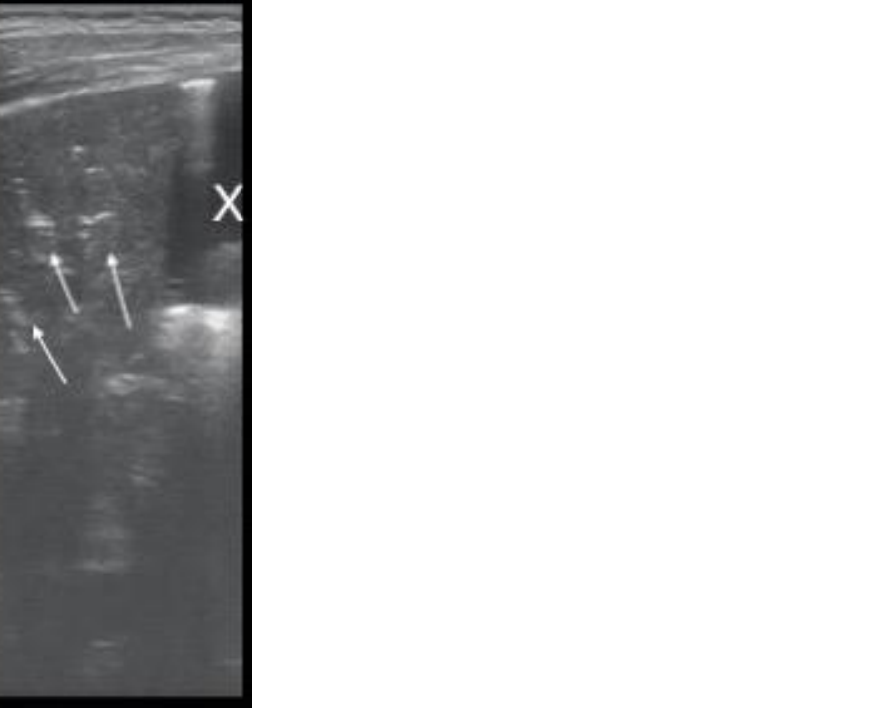
Figure 2. Left lower lobe pneumonia on CXR of the same case; no clear sign of pleurisy; apparently clear costal – diaphragmatic left angle.